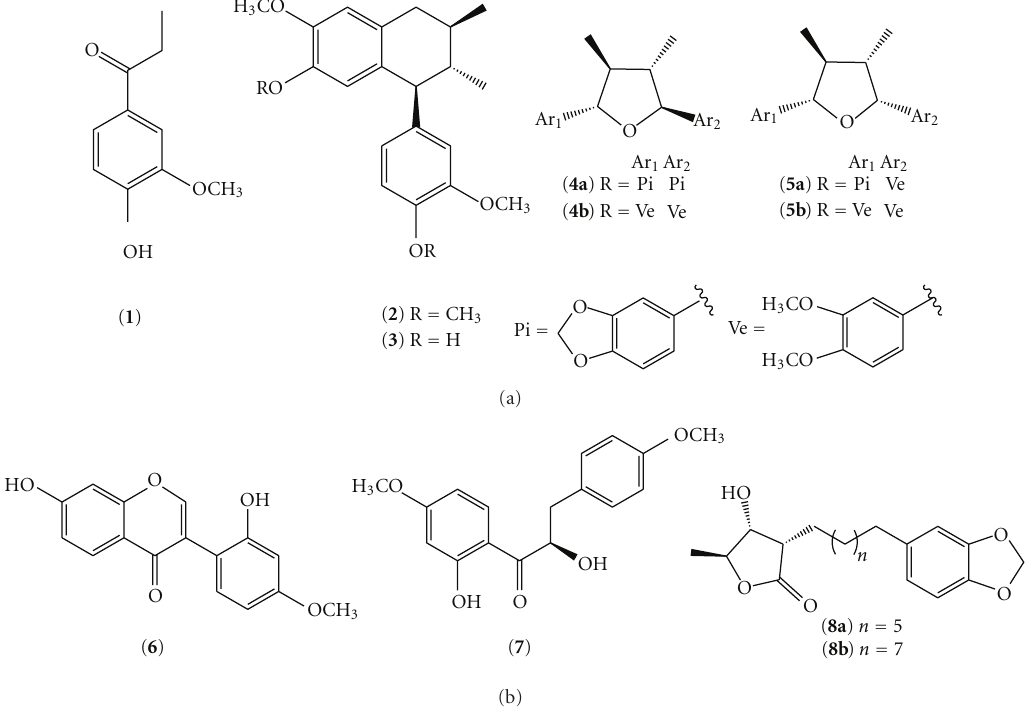
Figure 1: Chemical structures of the isolated substances: 4-hydroxy-3-methoxypropiophenone ( 1 ), galbulin ( 2 ), guaiacin ( 3 ), galbacin ( 4a ), galbelgin ( 4b ), calopeptin ( 5a ), veraguensin ( 5b ), 7,2 (cid:2) -dihydroxy-4 (cid:2) -methoxy-isoflavone ( 6 ), α ,2 (cid:2) -dihydroxy-4,4 (cid:2) -dimethoxydihydrochal- cone ( 7 ), juruenolide C ( 8a ), and juruenolide D ( 8b ).